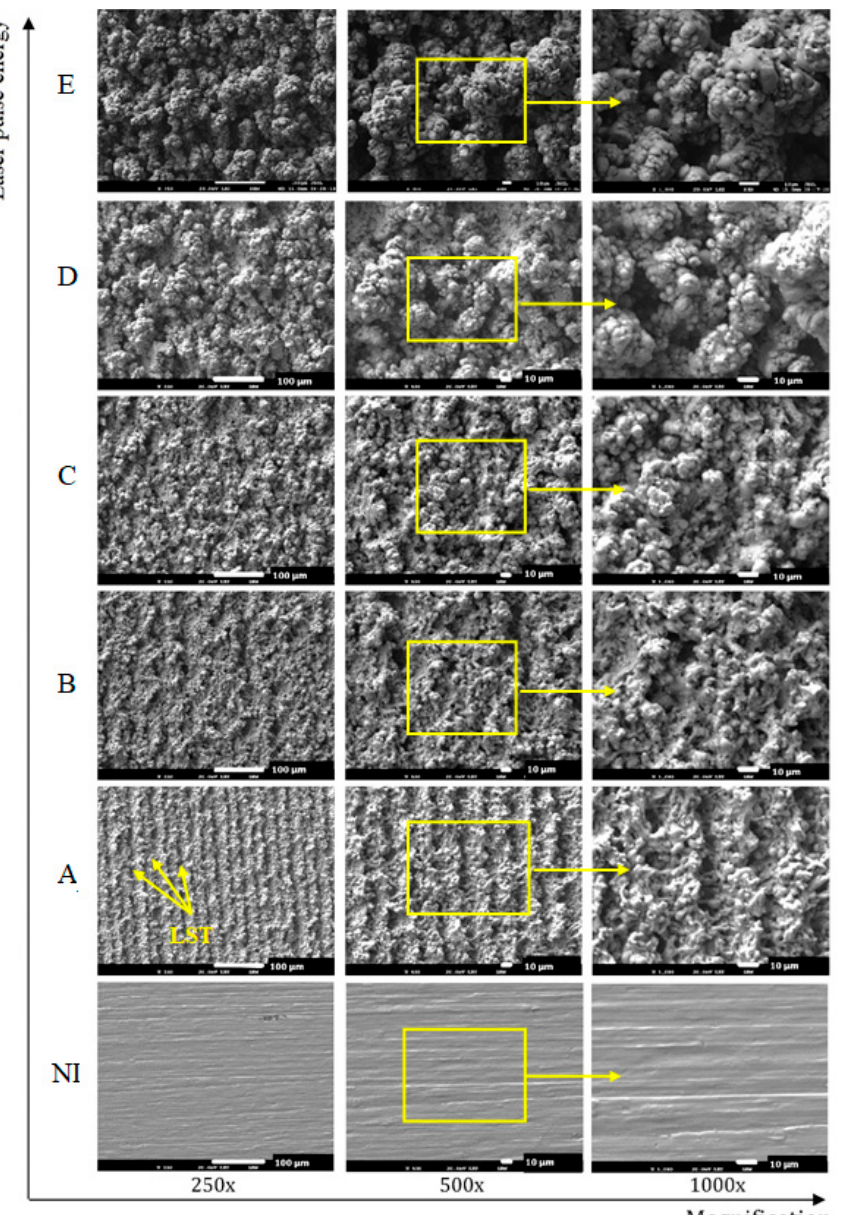
Figure 12. SEM images of the machined surfaces, showing the influence of the fluence on the surface morphology: NI—non-irradiated surface (Ra 0.25 µ m); Surface A (E p = 0.2 mJ, Ra 2.95 µ m); Surface B (E p = 0.4 mJ, Ra 4.71 µ m); Surface C (E p = 0.6 mJ, Ra 6.38 µ m), Surface D (E p = 0.8 mJ, Ra 9.56 µ m), Surface E (E p = 1 mJ, Ra 11.67 µ m); LST - Laser Scanning Tracks.